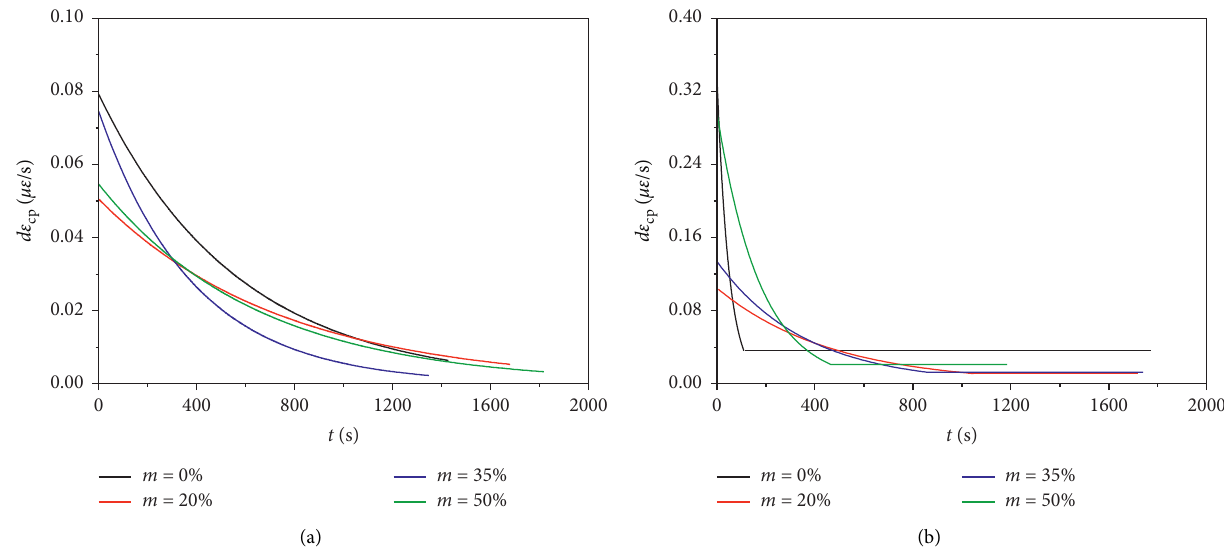
Figure 9: Creep rate-time ( dε cp - t ) curves of concrete with various fly ash replacement ratios ( m ) during the (a) decelerating and (b) decelerating/ isokinetic creep stages.